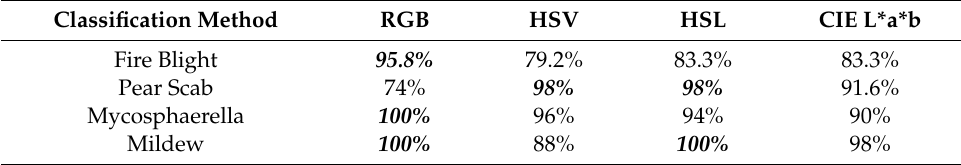
Table 8. Sensitivity of pear disease diagnosis when linear dynamic range expansion (DRE) normalization is employed. The color space with the best sensitivity for each disease is highlighted with